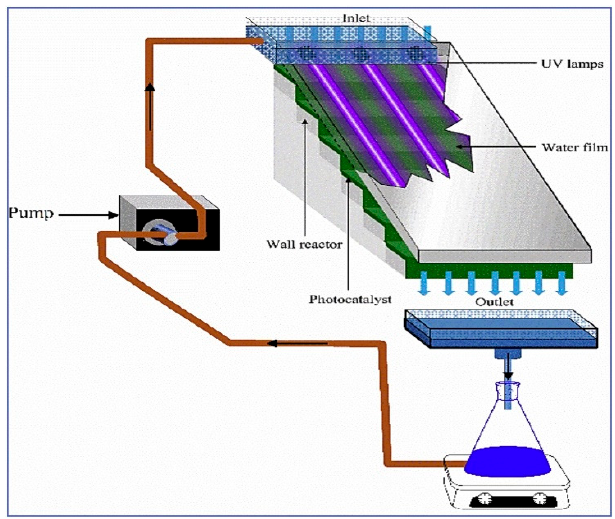
Figure 5. Representation of the pilot scale system composed by pump, UV lamp and photocatalyst. The dark arrow denotes the water circulation. Reprinted from Zeghioud et al. [87] Copyright (2019), with permission from Elsevier .